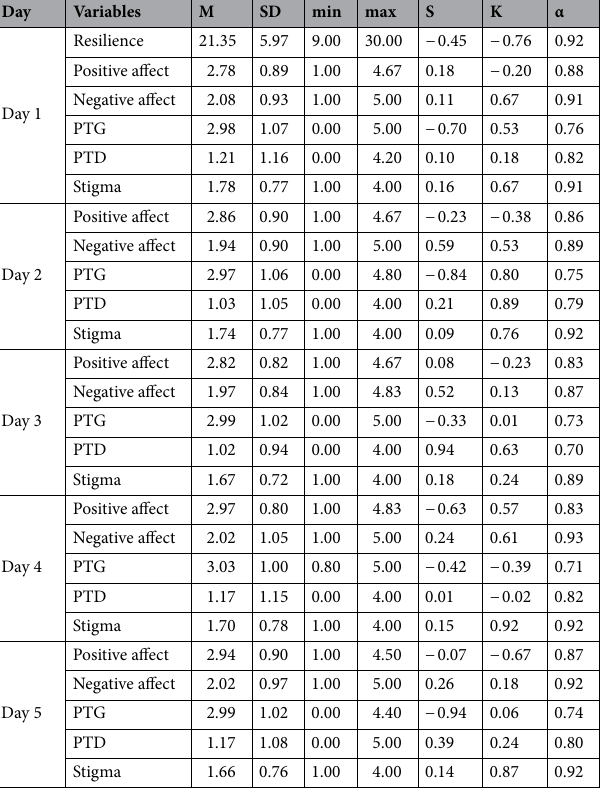
Table 2. Descriptive statistics of analyzed variables among participants. M mean value, SD standard deviation, min minimum value, max maximum value, S skewness, K kurtosis; α Cronbach’s α reliability